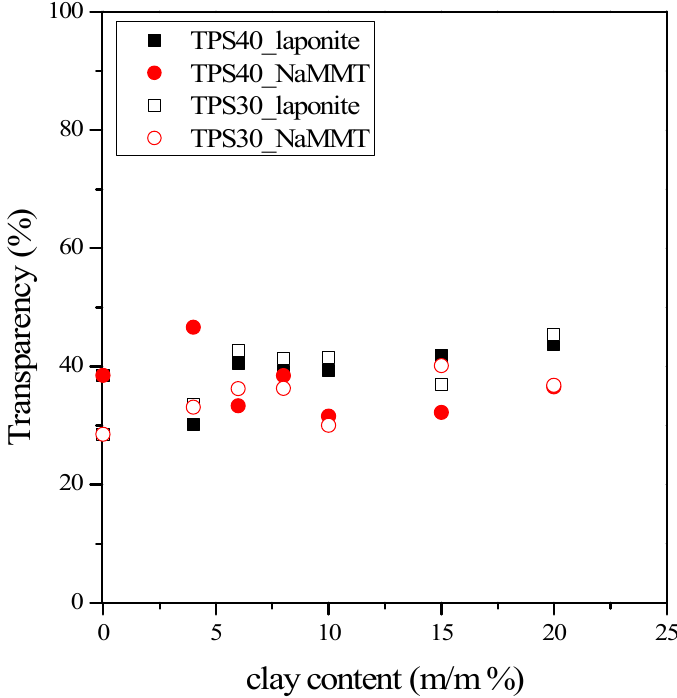
Figure 6. Effect of clay content on the transparency of different TPS/clay composites.